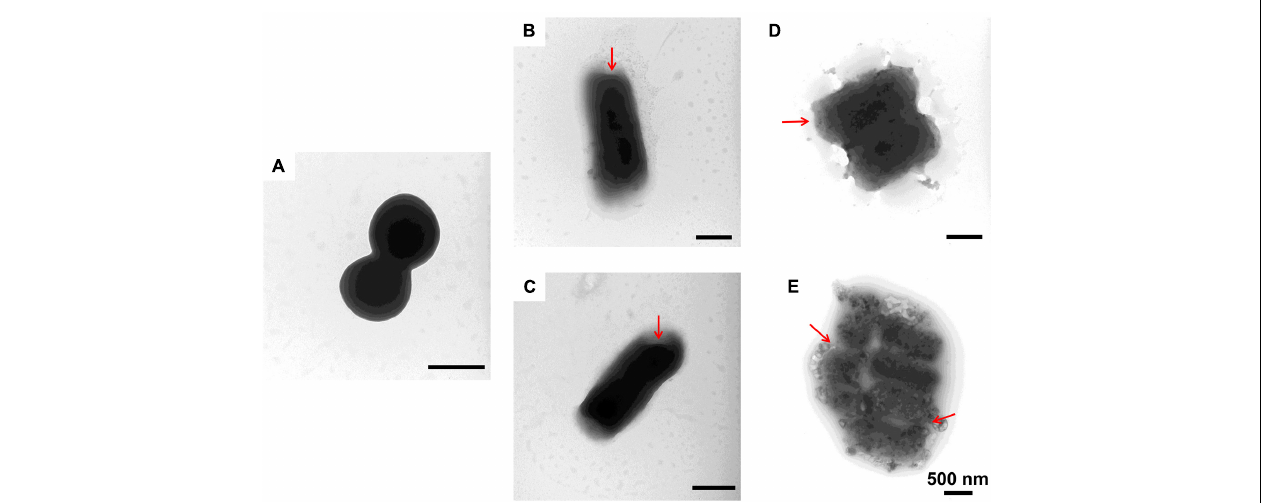
FIGURE 5 | Transmission electron microscopic observation of M. luteus . M. luteus incubated with PBS (A) or with 1–6, P-6, S-6, and L-6 (B–E) at 28 ◦ C for 30 min. The red arrow points to where the cell membrane has broken and the cell contents have flowed out.